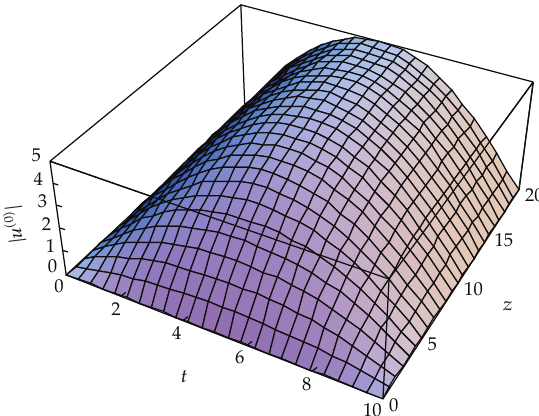
Figure 1: The zero-order approximation of | u (cid:3) 0 (cid:4) | at α (cid:8) 1, T (cid:8) 10, γ (cid:8) 02 with considering only one term in the series (cid:3) M (cid:8) 1 (cid:4) .